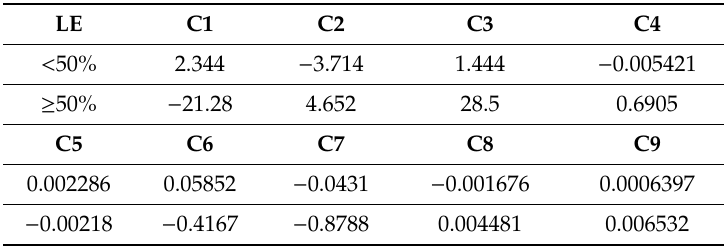
Table 4. Coe ffi cients for the Spd